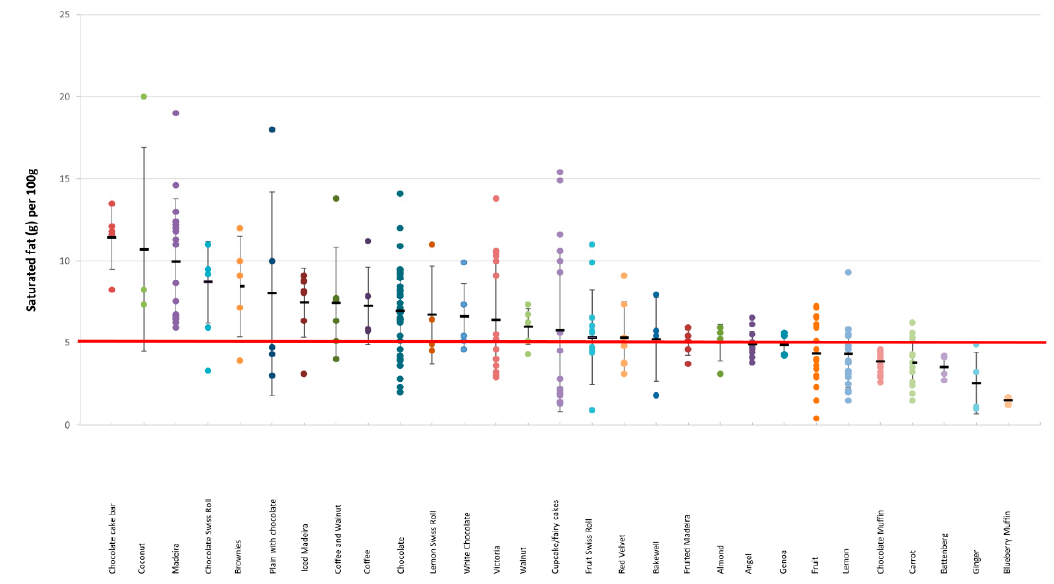
Figure 3. Saturated fat content (g/100 g) in different categories of cakes. The red line denotes the high criteria for saturated fat.